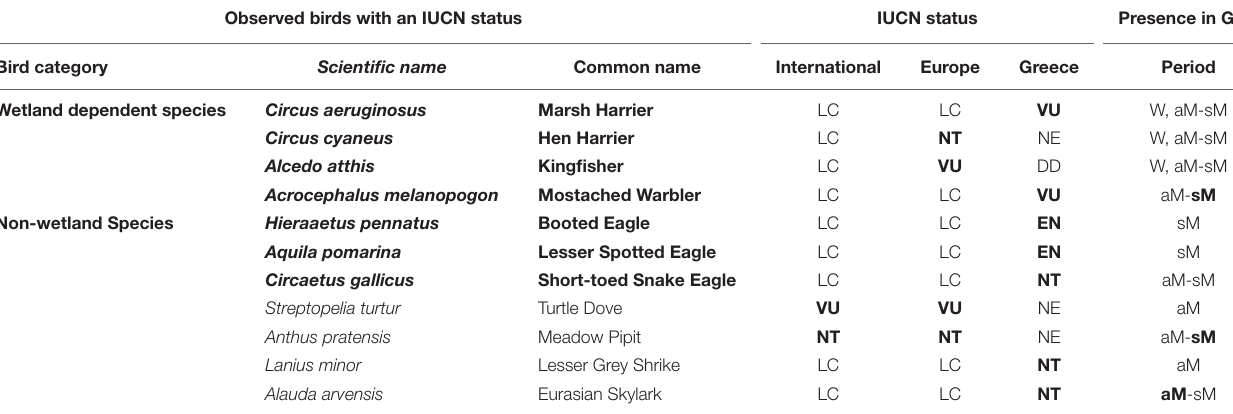
TABLE 7 | Observed birds in GLw-Natura2000 which are threatened at International, European and Greek level. Observed birds with an IUCN